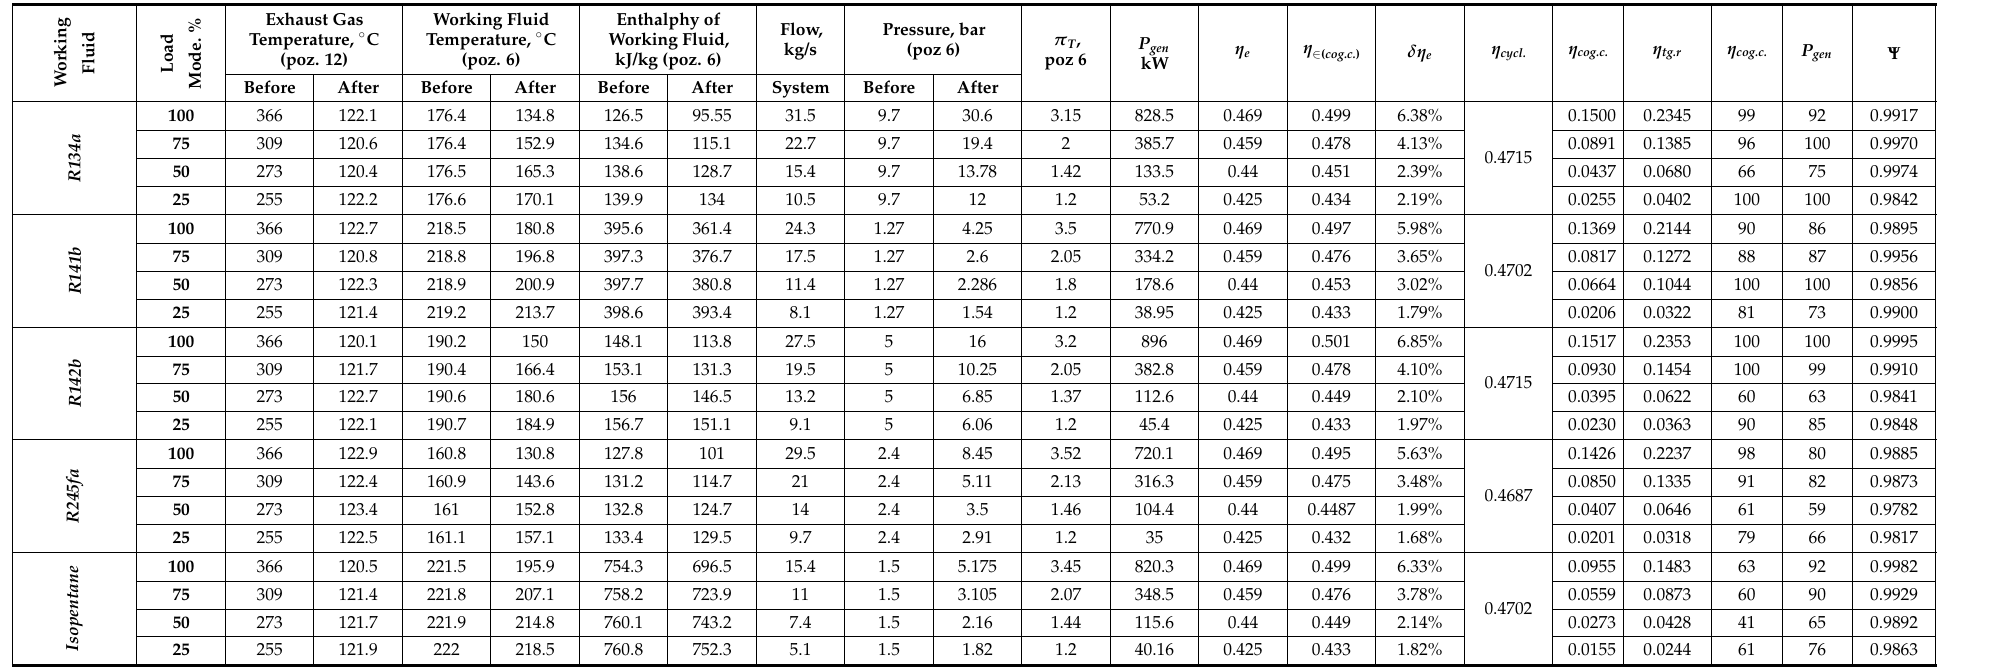
Table 7. Results of cycle simulation: strategy G w.fl. − π T (determined on the classical theory of turbo machines